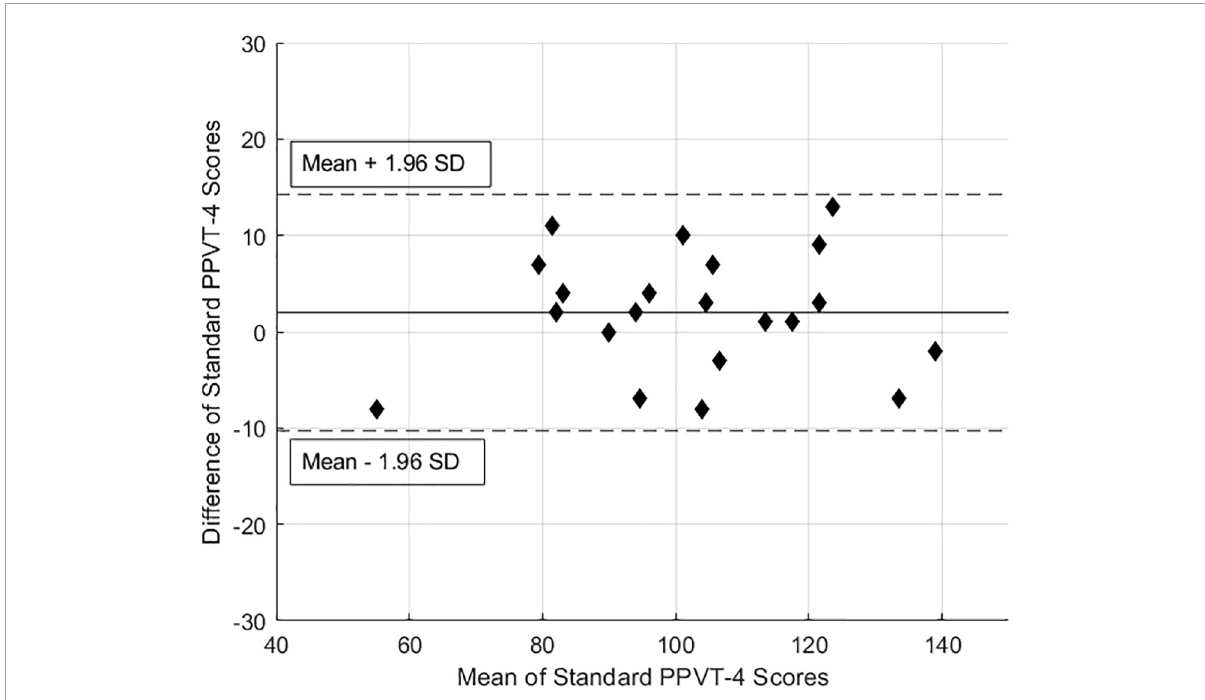
FIGURE2 Bland-Altman plot of the mean of PPVT-4 standard and BCI-facilitated scores against the difference in